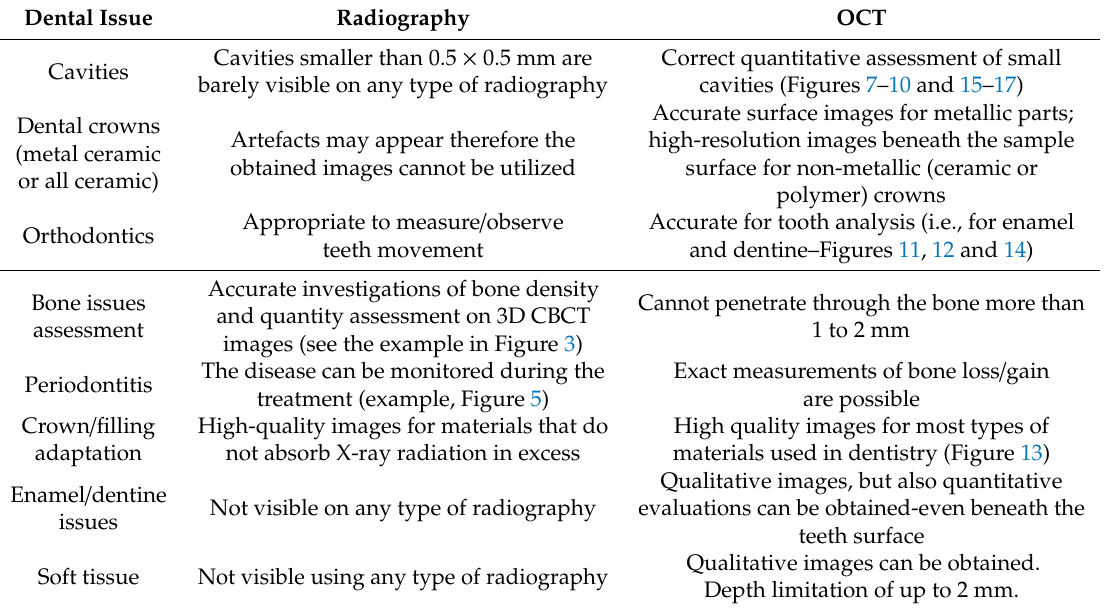
Table 3. Medical imaging technique suitable for selected dental